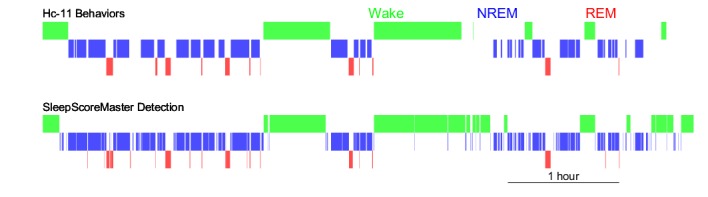
Automatic behavior state detection.Wake (green), NREM (blue), and REM (red) periods detected by SleepScorreMaster (bottom) based on LFPs and LFP-reconstructed-EMG were similar to those detected manually (top) based on LFPs (theta-delta ratio), EMG, and video in one example rat.